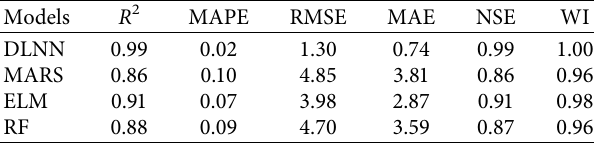
Table 7: Statistical measurements for the developed AI model in the test phase by using 80-20% data division scenario.